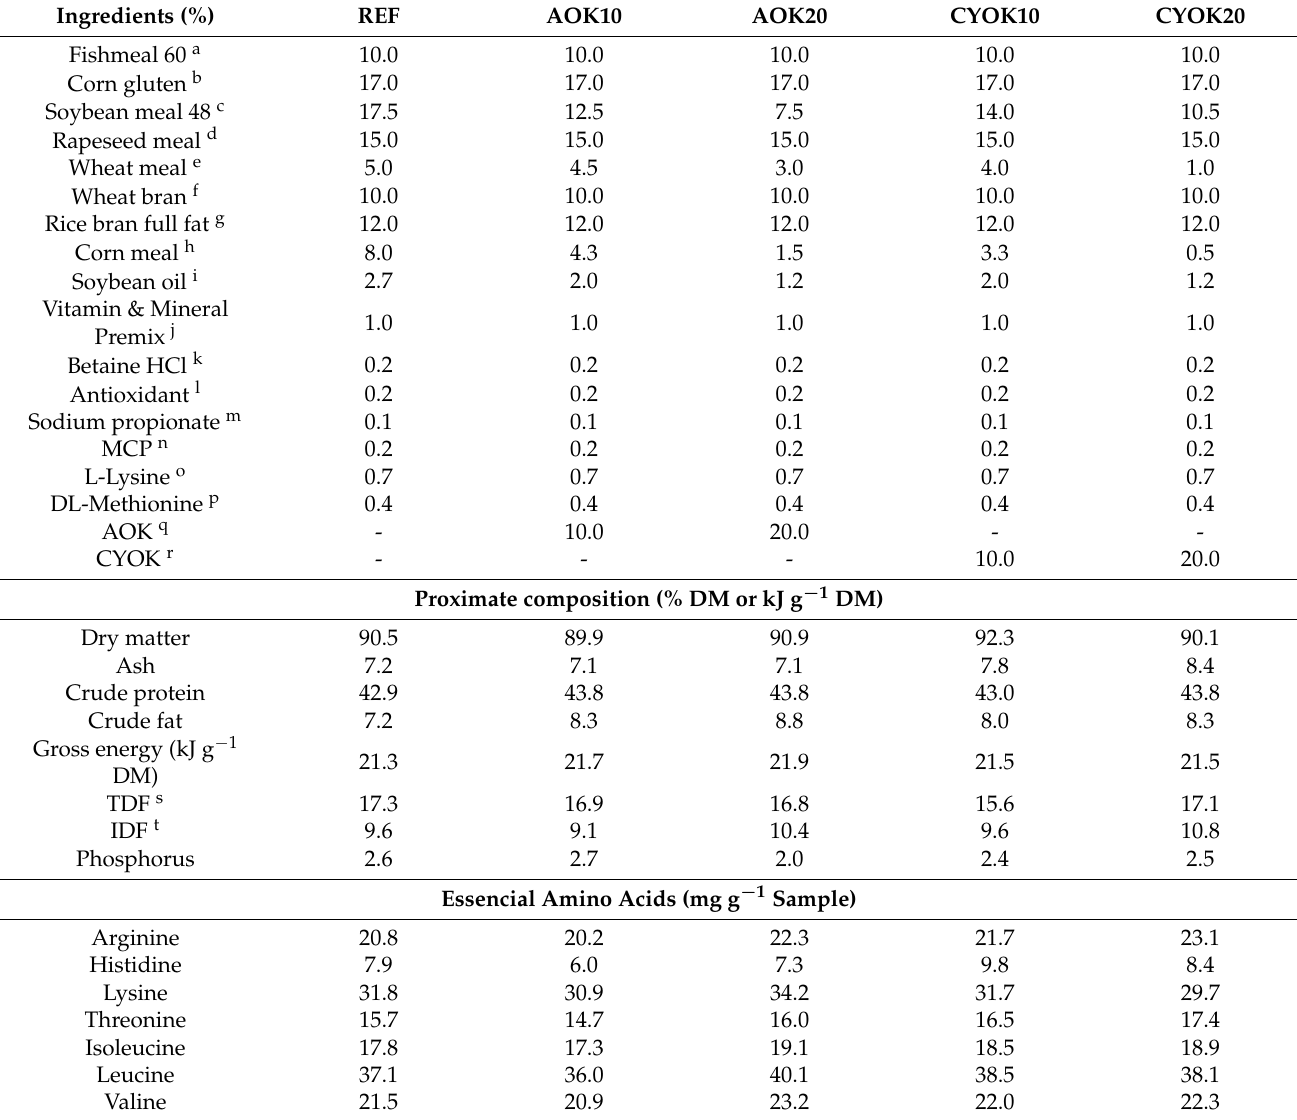
Table 4. Formulation and proximate composition of the experimental diets and ingredient used in the growth